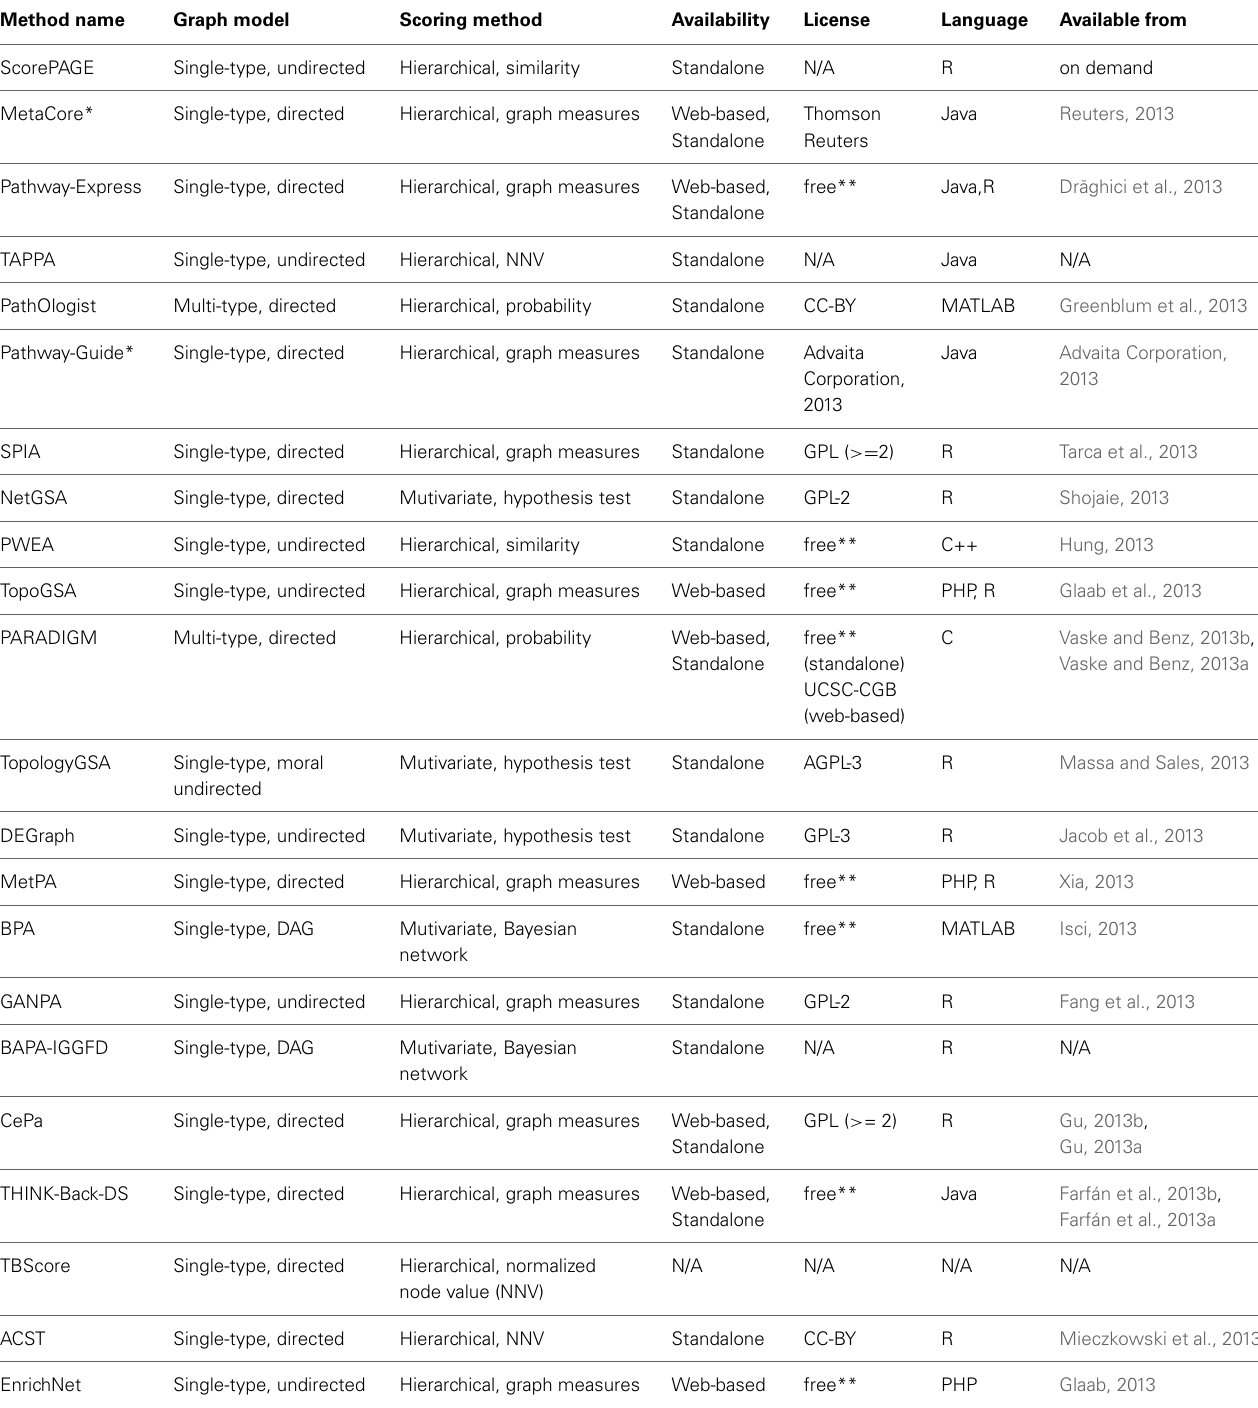
Table 2 | Comparison of topology-based pathway analysis methods using criteria related to the mathematical model and